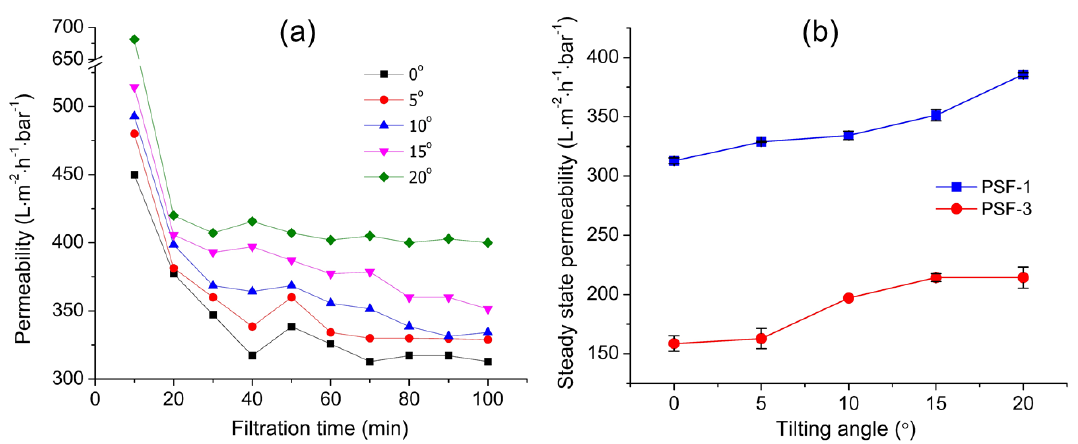
Figure 4. The effects of tilting angle on the permeability performance in terms of filtration time ( a ) and steady state permeability ( b ).